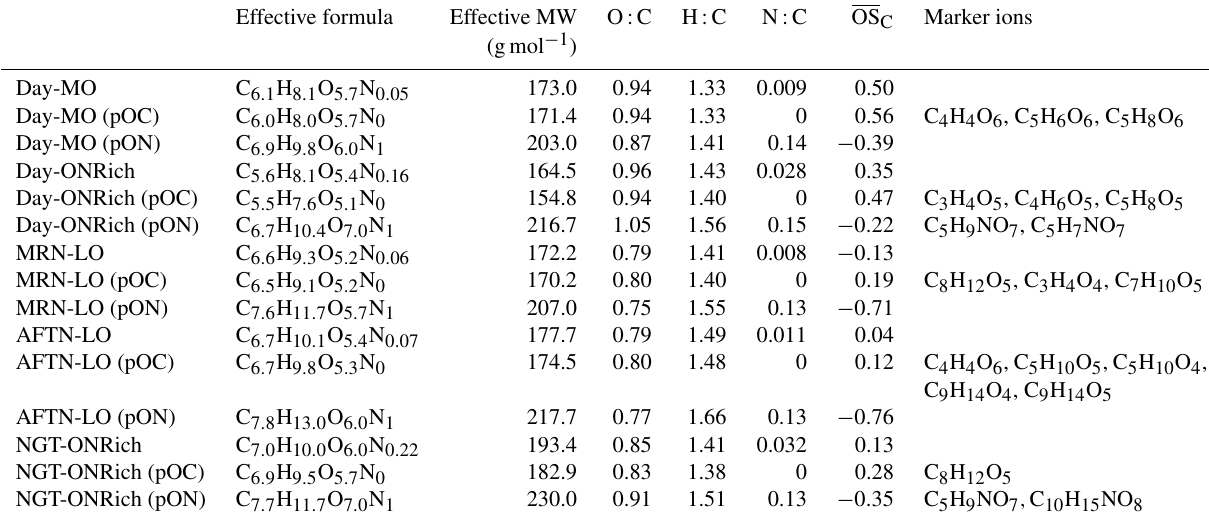
Table 1. Effective molecular composition of FIGAERO factors. Effective formula Effective MW O:C